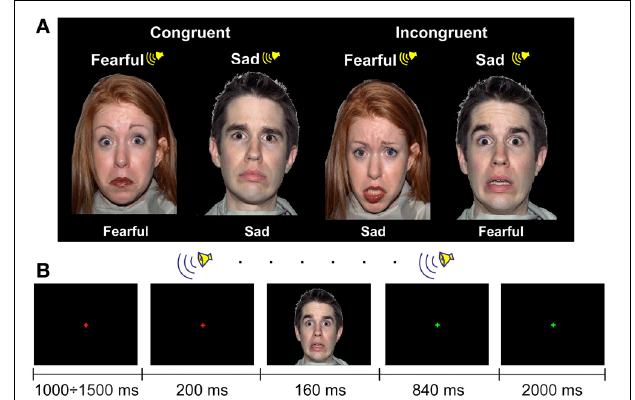
FIGURE 2 | The examples of the stimuli (A) and the procedure (B) in the FACE